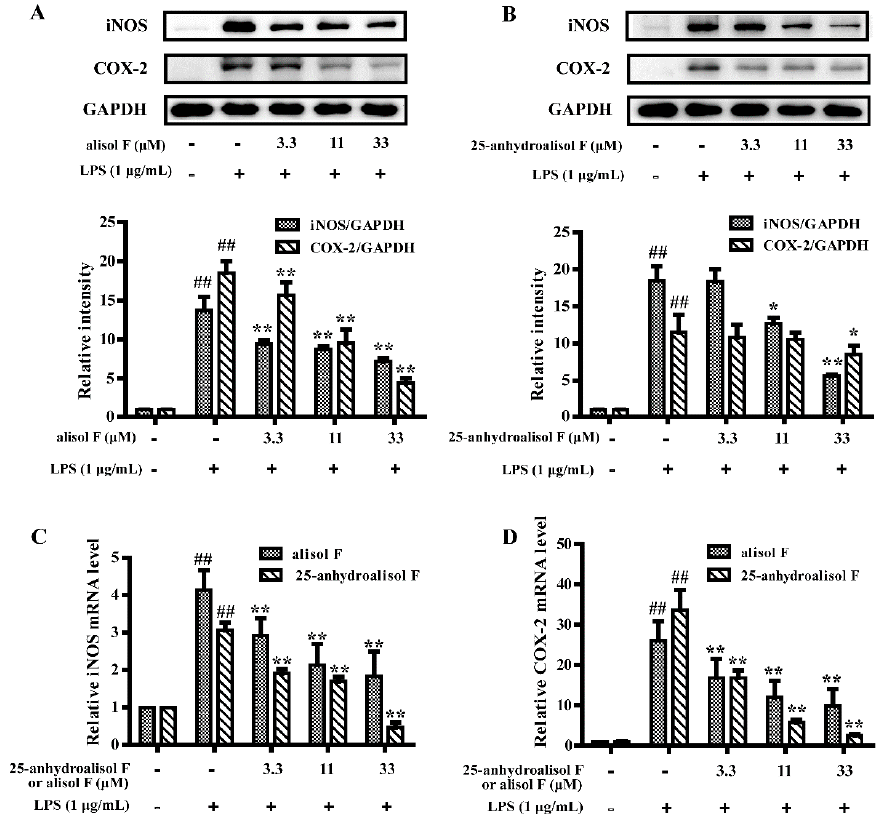
Figure 2. The effect of alisol F and 25-anhydroalisol F on the expression of iNOS and COX-2 in LPS-stimulated RAW 264.7 cells. Cells were pretreated with the various concentrations of alisol F (0, 3.3, 11 and 33 μ M) and 25-anhydroalisol F (0, 3.3, 11 and 33 μ M) for 2 h and then stimulated with or without LPS (1 μ g/mL) for 24 h. The expression of iNOS and COX-2 protein levels were analyzed by Western blot ( A , B ); Cells were pretreated in the same way for 2 h and then stimulated with or without LPS (1 μ g/mL) for 4 h. The expression of iNOS and COX-2 mRNA levels were measured by quantitative real-time PCR ( C , D ). The data represent the means ± S.E. of three independent experiments. ( ## p < 0.001 vs. control group; * p < 0.05, ** p < 0.001 vs. LPS group).